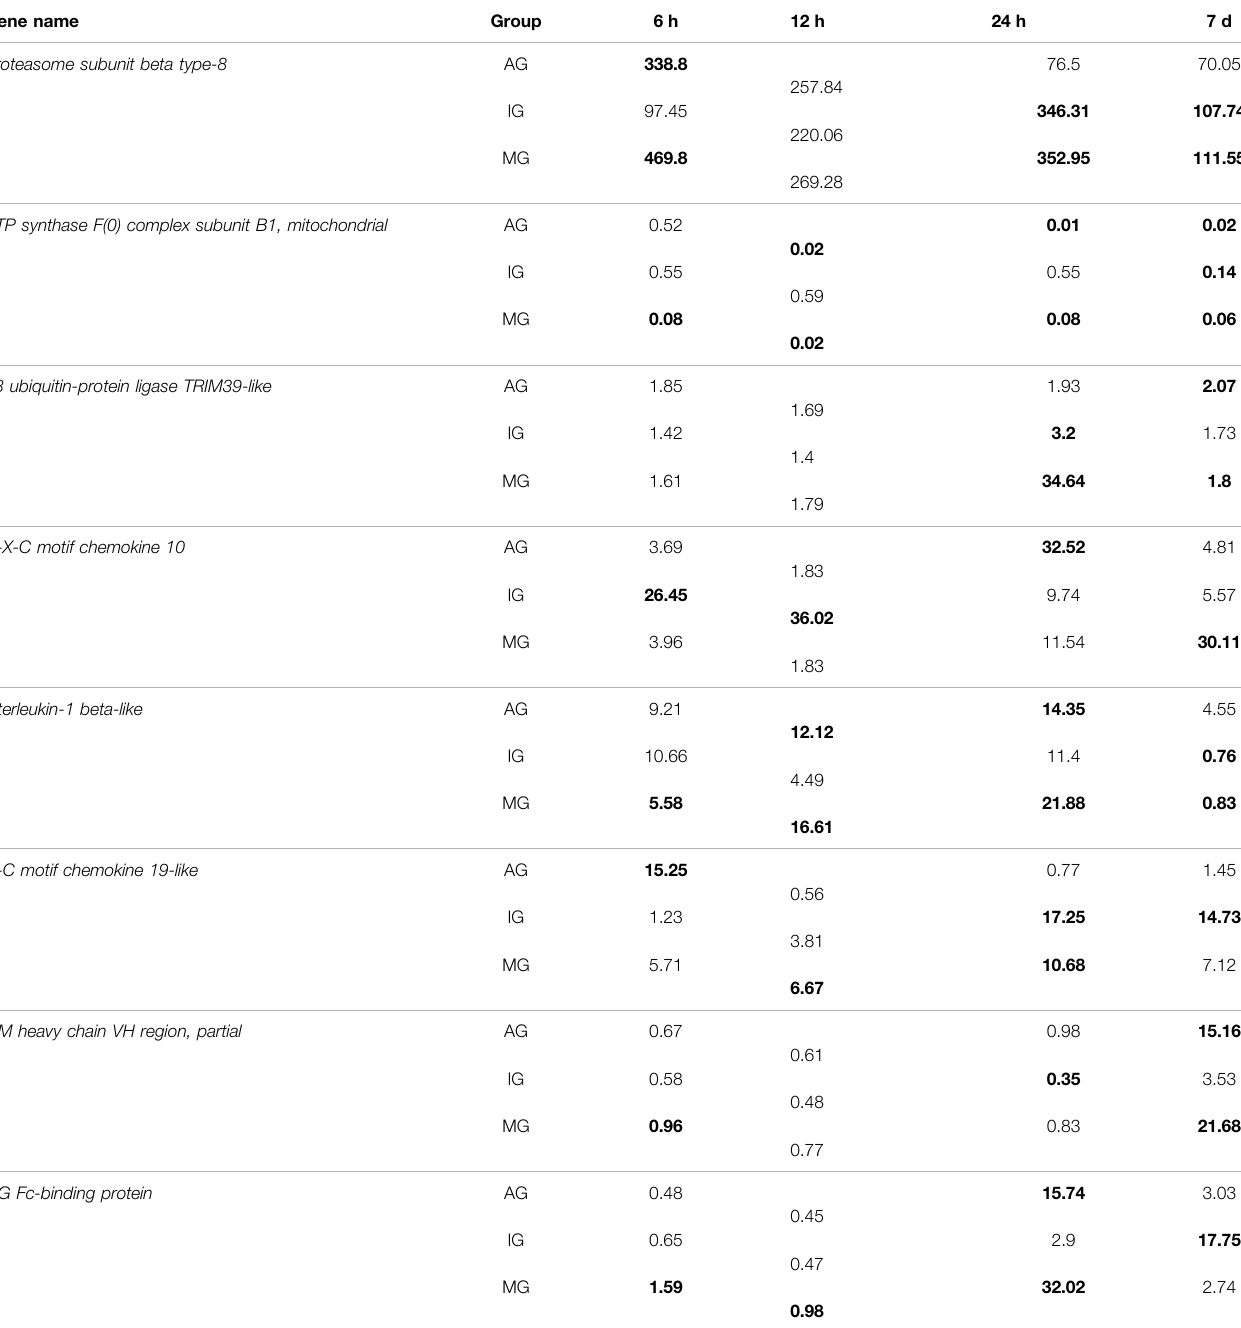
TABLE 2 | Differentially expressed immune-related genes from O. niloticus following Streptococcus